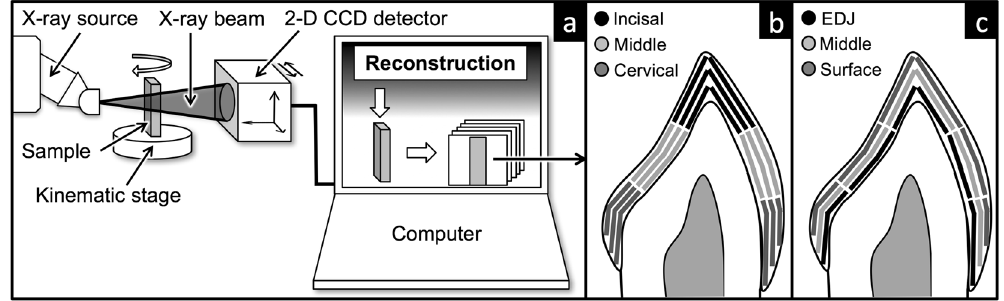
Figure 9. Schematic diagram of ( a ) the XMT experimental setup using the MuCAT 2 scanner (QMUL) and a typical XMT slice showing the 18 regions and how they are divided for ( b ) vertical and ( c ) horizontal